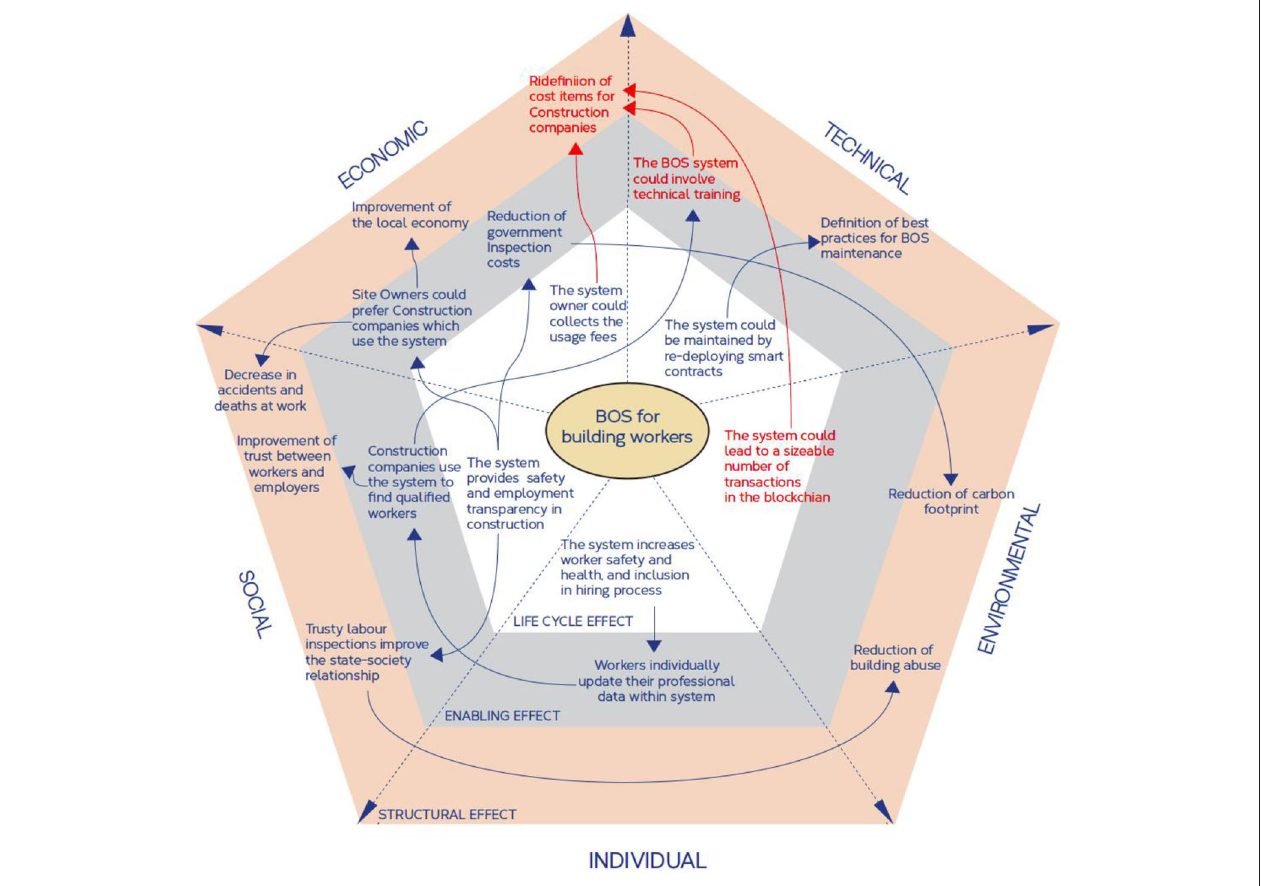
FIGURE 3 | The sustainability awareness diagram we created to better understand the system and its potential effects in the five sustainability dimensions. In red are the potential effects that could represent a threat to the sustainability.